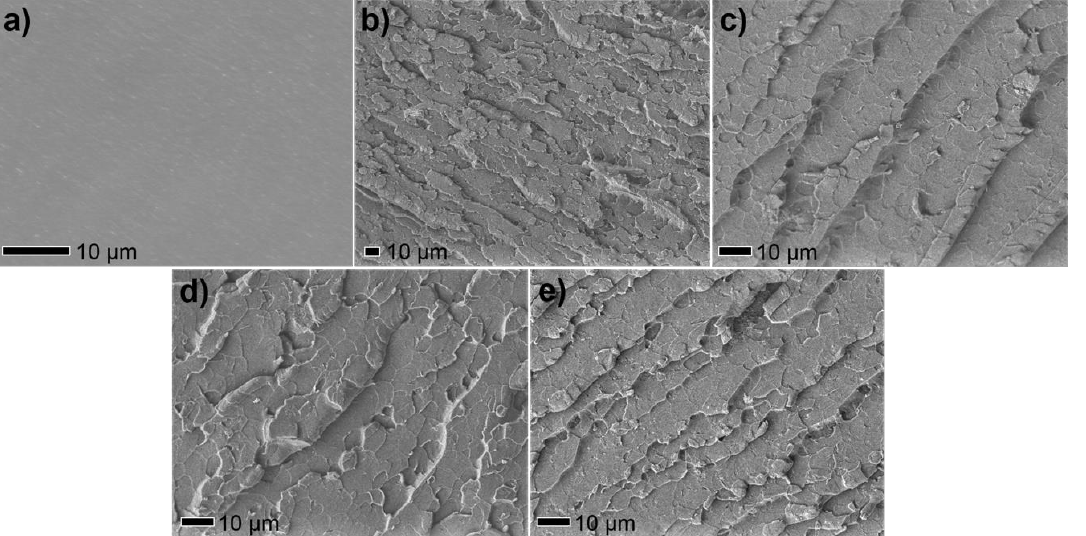
Figure 7. SEM images of fracture surfaces cryogenically broken after immersion in liquid nitrogen of ( a ) pure EP, ( b ) EP / MnO 2 2%, ( c ) EP / MnO 2 @ZHS 0.5%, ( d ) EP / MnO 2 @ZHS 1%, and (e) EP / MnO 2 @ZHS